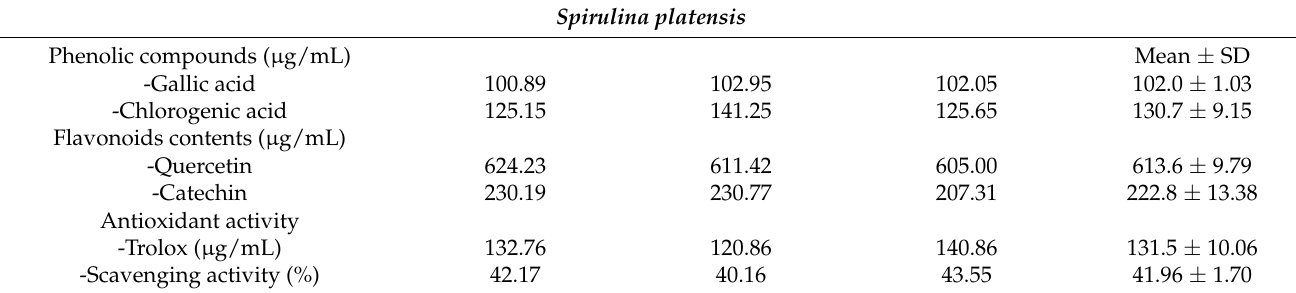
Table 2. Total phenolic compounds, flavonoids content, and antioxidant activity of Spirulina platensis . Spirulina